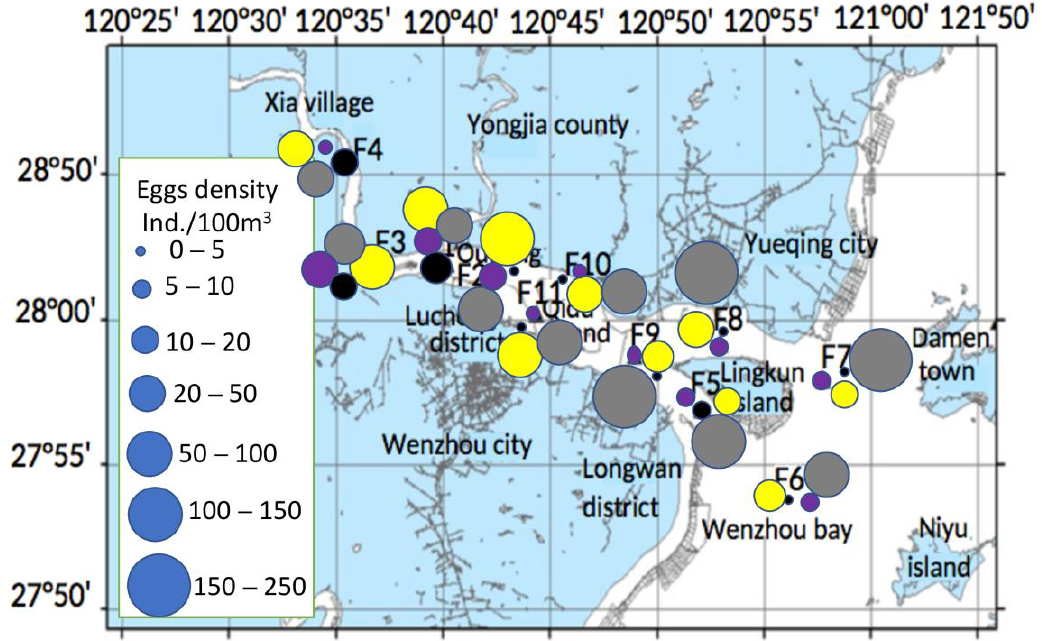
Figure 3. Spatial-temporal distribution of fish eggs in Oujiang River Estuary: Each sampling month is indicated with a specific color: black = May, yellow = June, grey = July and purple = August. The size of circle reflects the density of eggs in a specific site.